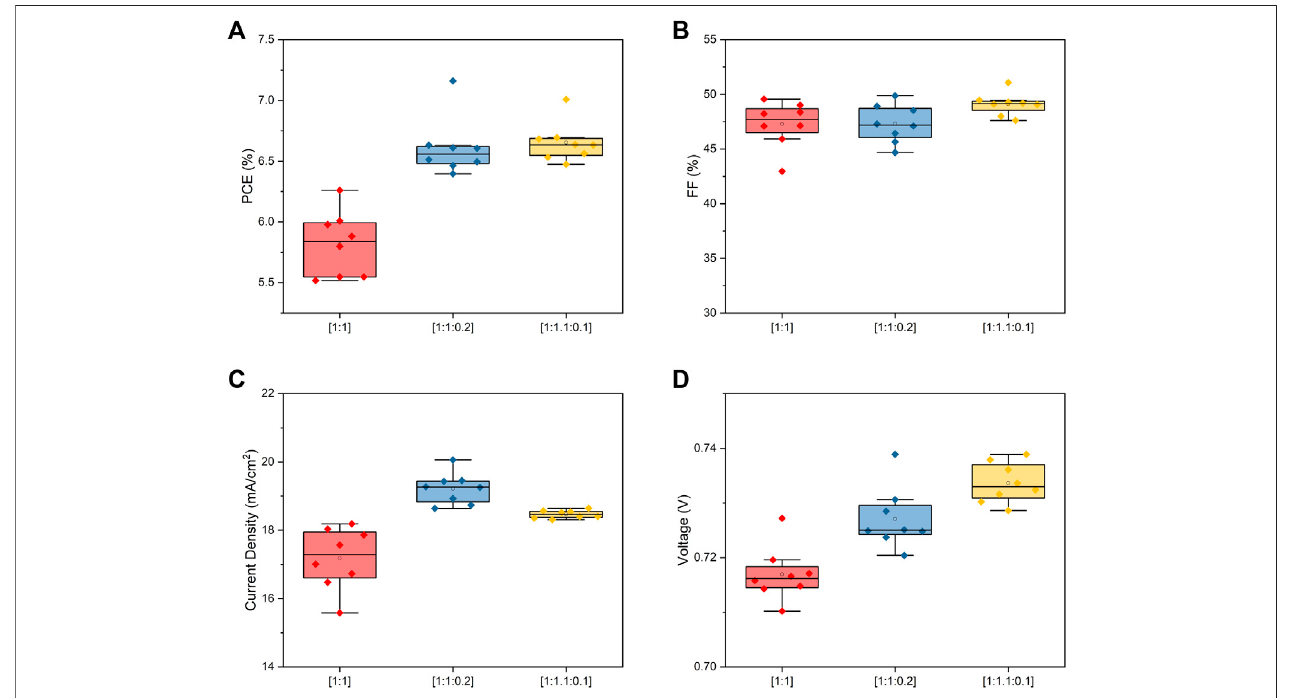
FIGURE 7 | Comparison of PV parameters between binary and ternary devices for (A) PCE, (B) FF, (C) current density (J sc ) and (D) open-circuit voltage (V oc ).